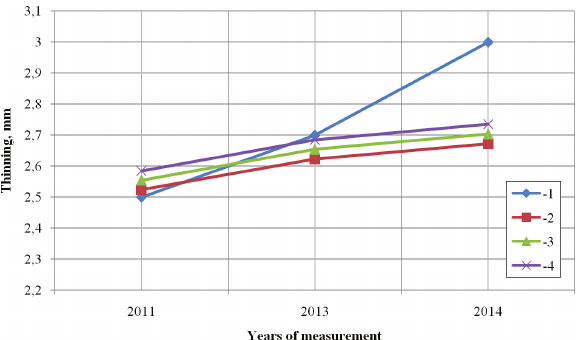
Figure 3. Predictive estimates obtained using EKI-02 at close values of the Cr concentration in the metal: 1 – measurements; 2 – Cr = 0.0752; 3 – Cr = 0.0741; 4 – Cr =